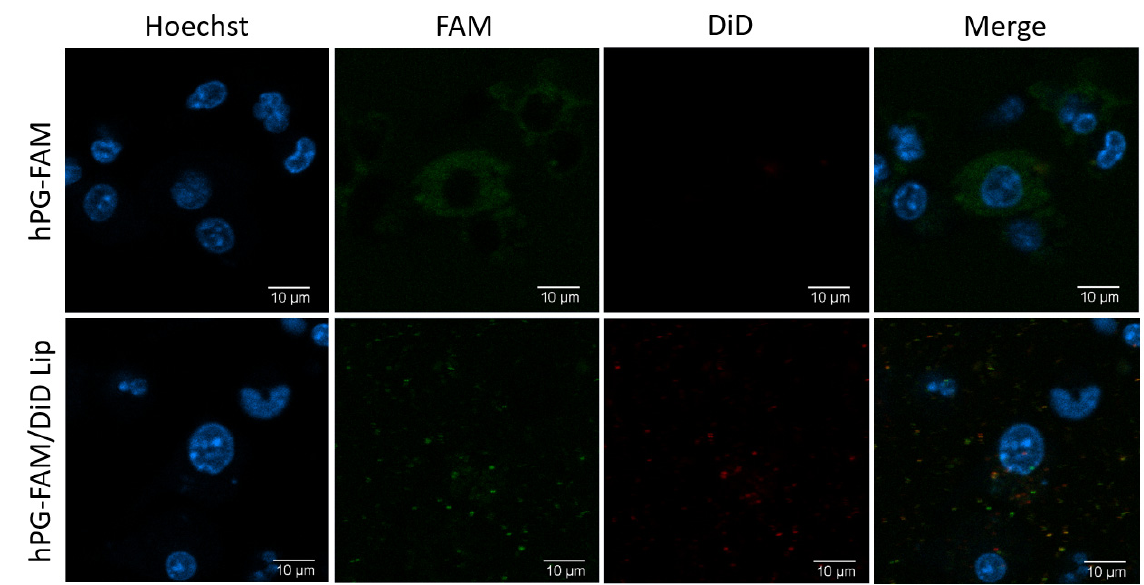
Figure 4. Peptide encapsulation in liposomes enhances uptake by BMDCs in vitro. BMDCs were stimulated with LPS and cultured in the presence of hPG-FAM added freely or encapsulated in DiD-labeled liposomes. After 24 h of incubation, cells were washed to remove unbound antigen and liposomes. The blue signal shows the Hoechst staining, the green signal indicates the presence of hPG-FAM and in red is the liposomal dye. The scale bar shows 10 μ m. N = 1.